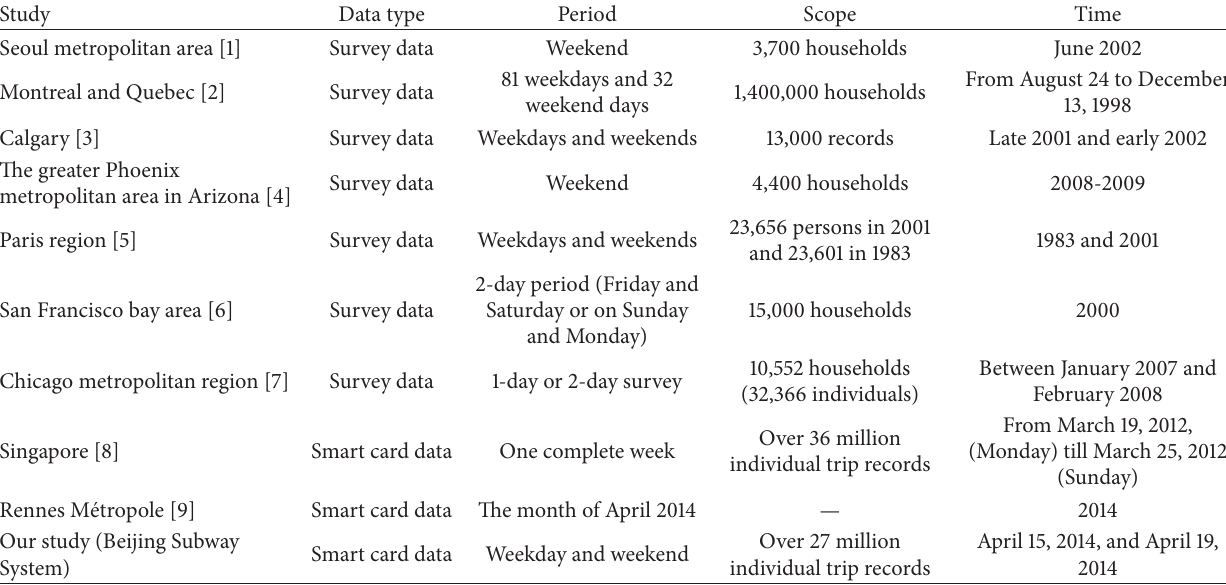
Table 1: Parameters used in studies of different travel behaviors on weekdays and